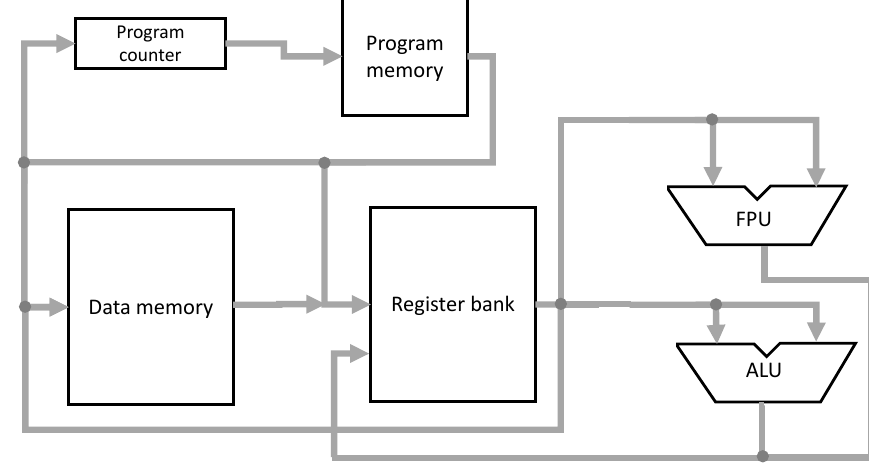
Figure 12. Simplified view of the monocycle architecture of PAMPIUM.